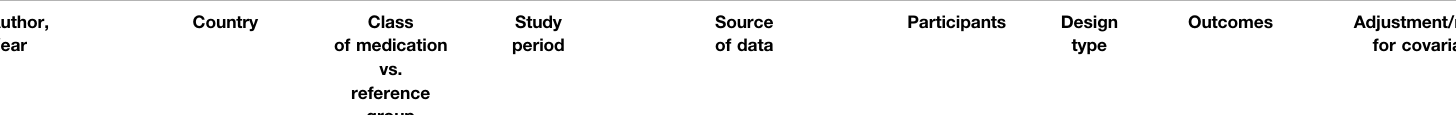
TABLE 1 | Characteristics of the articles included in the